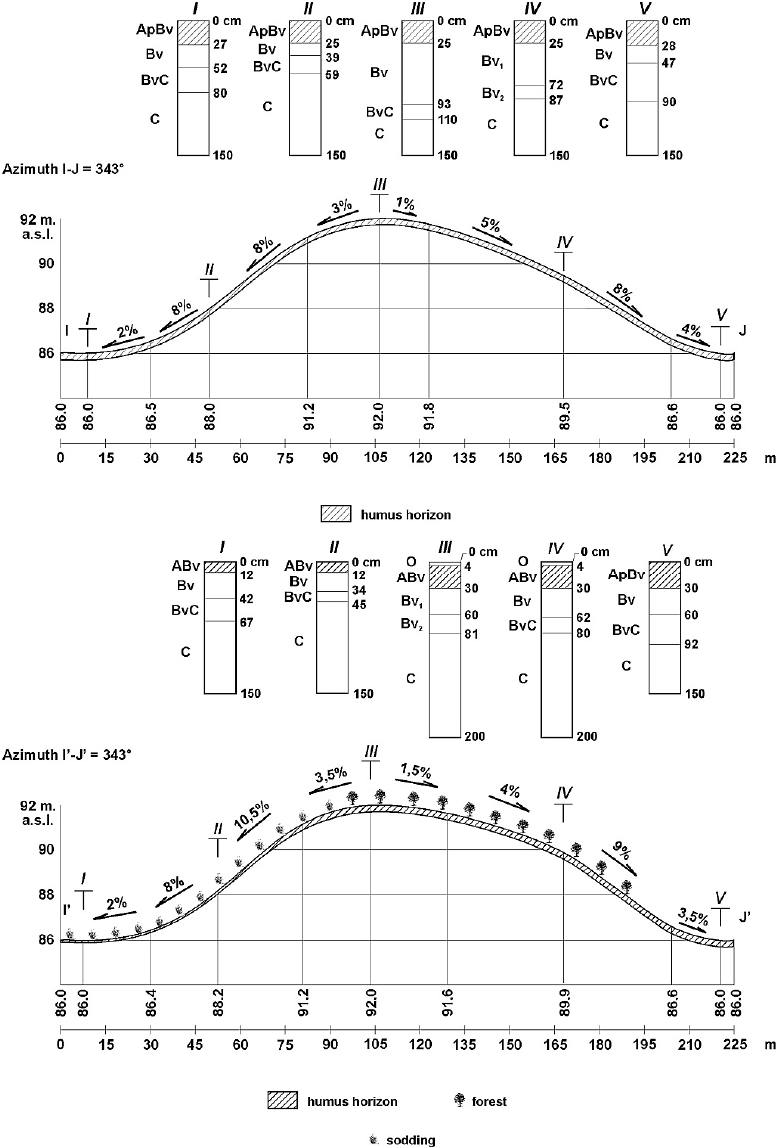
Figure 5. The soil cross sections I-J and I’-J’. Slope gradient in%; A: humus horizon; B: enrichment horizon; C: parent material (substratum); O: organic horizon; p : plow layer; v: occurrence of plinthite [39].